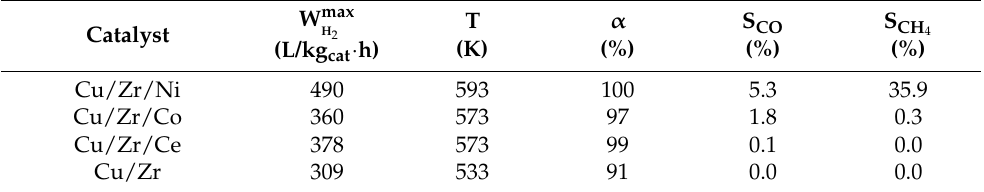
Table 3. Maximum hydrogen yield at corresponding temperature for tested